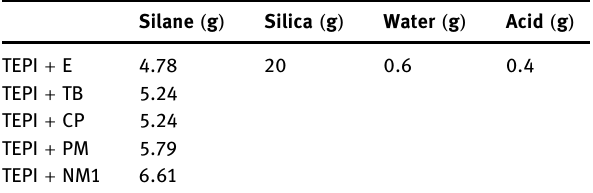
Table 2: Ingredients for the modi fi cation process Silane ( g